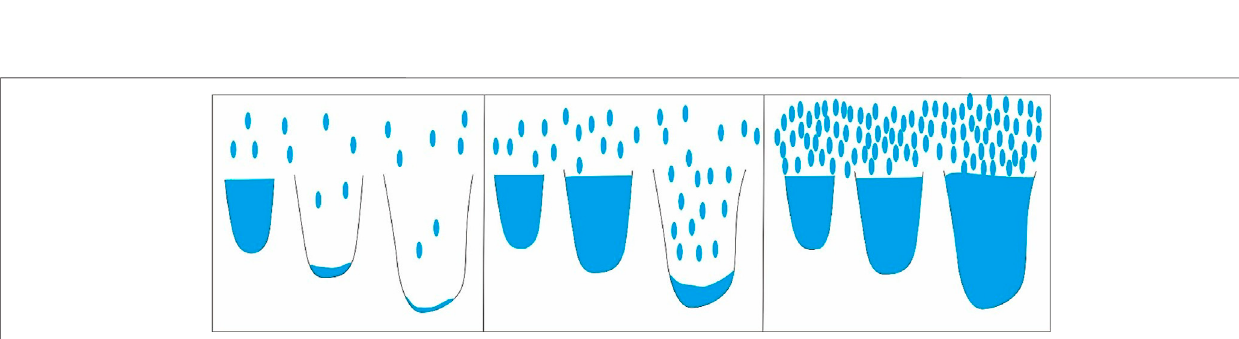
fi tted results of the three-parameter Langmuir model ( Figure 10 ) showed that with increasing sample moisture content, the methane adsorption capacity decreased gradually.